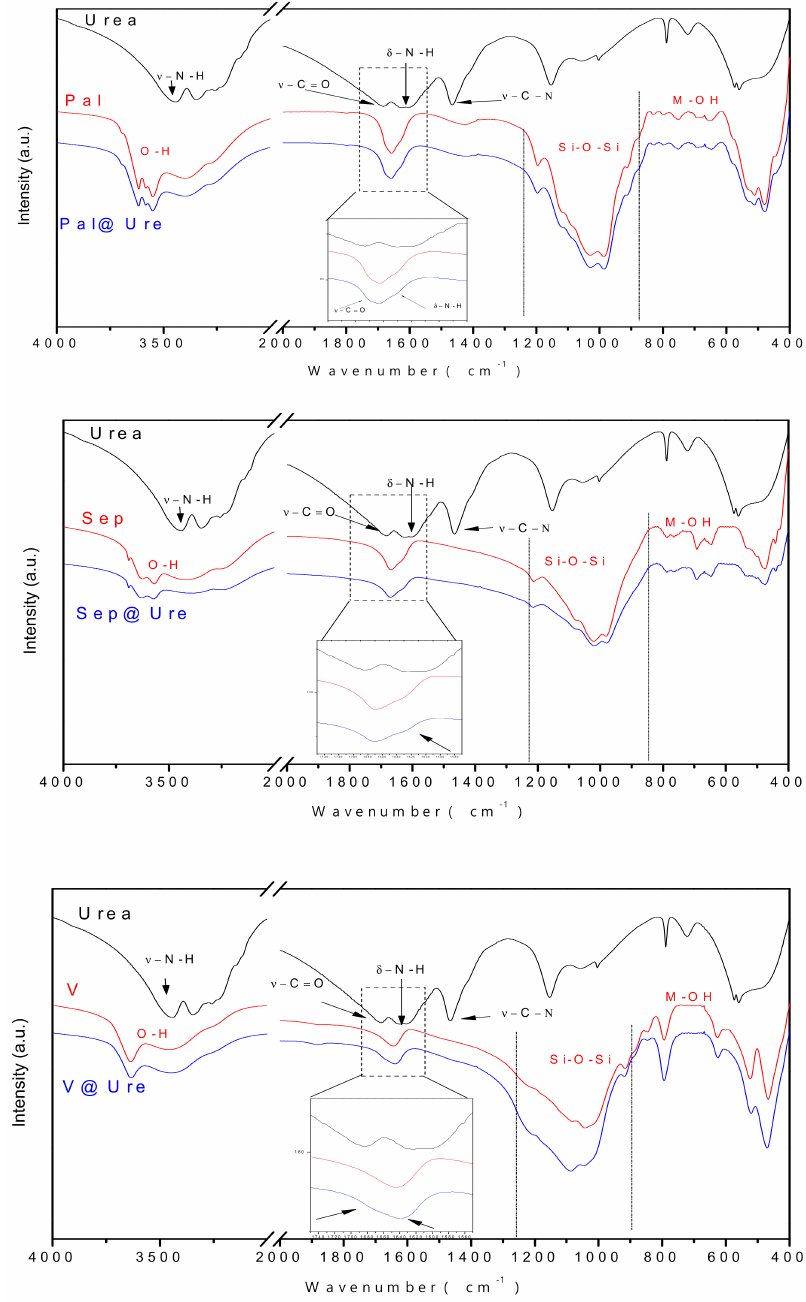
Figure 5. FTIR of urea and the clay minerals before and after urea encapsulation.